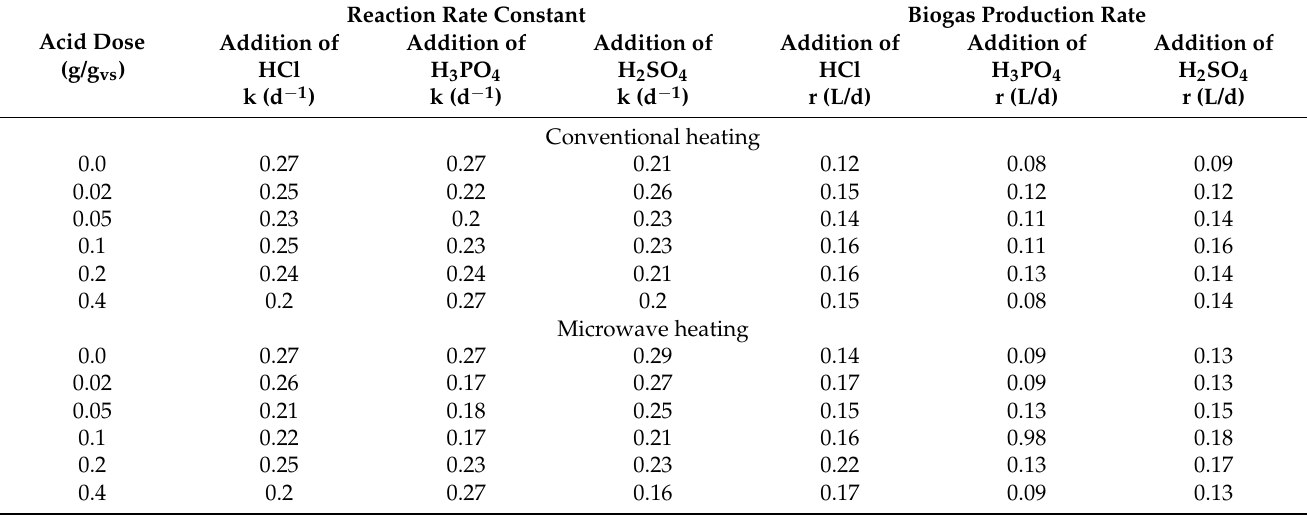
Table 5. Biogas production rate depending on heating method and acid